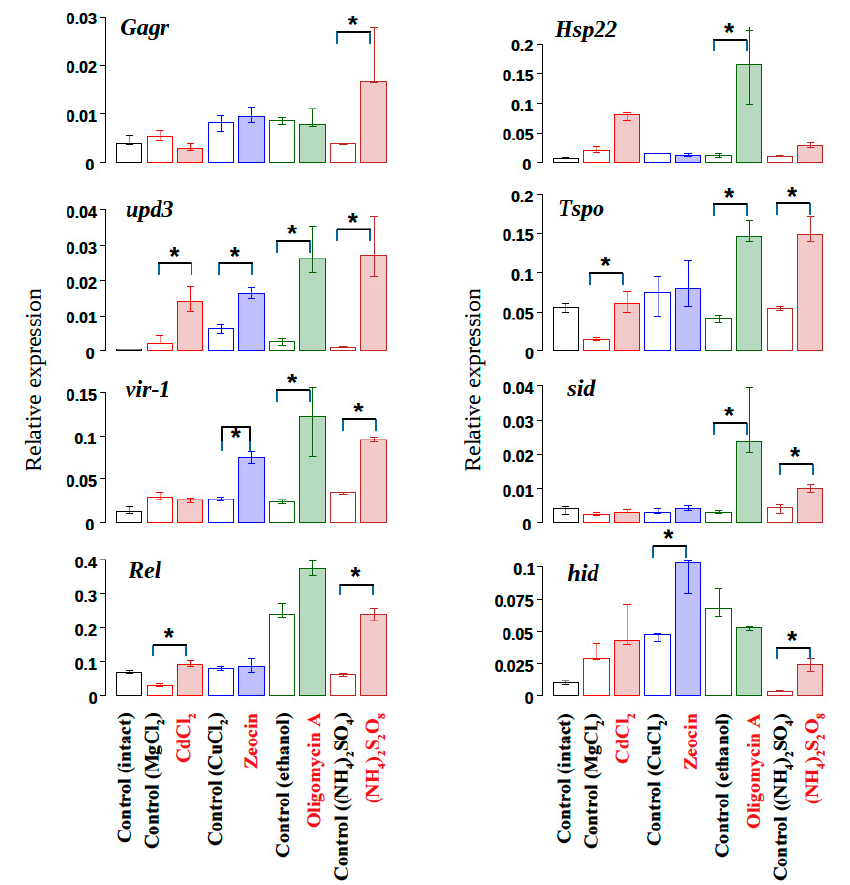
Figure 2. Analysis of the expression of Gagr and stress-induced genes in D. melanogaster females in response to various stress agents after 24 h exposure. * - significant differences in exposure relative to control (Mann-Whitney test, p -value < 0.01, N = 5-7). The data are presented as median and